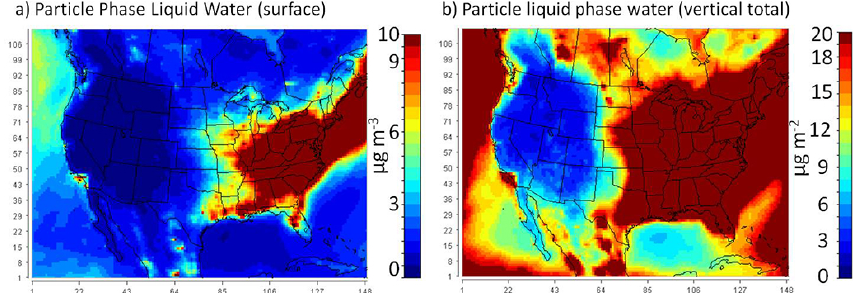
Fig. 4. (a) Particle-phase liquid water concentrations at the surface (0–34m) and (b) for the model column (surface up to 100mb). Values are July 2003 averages.